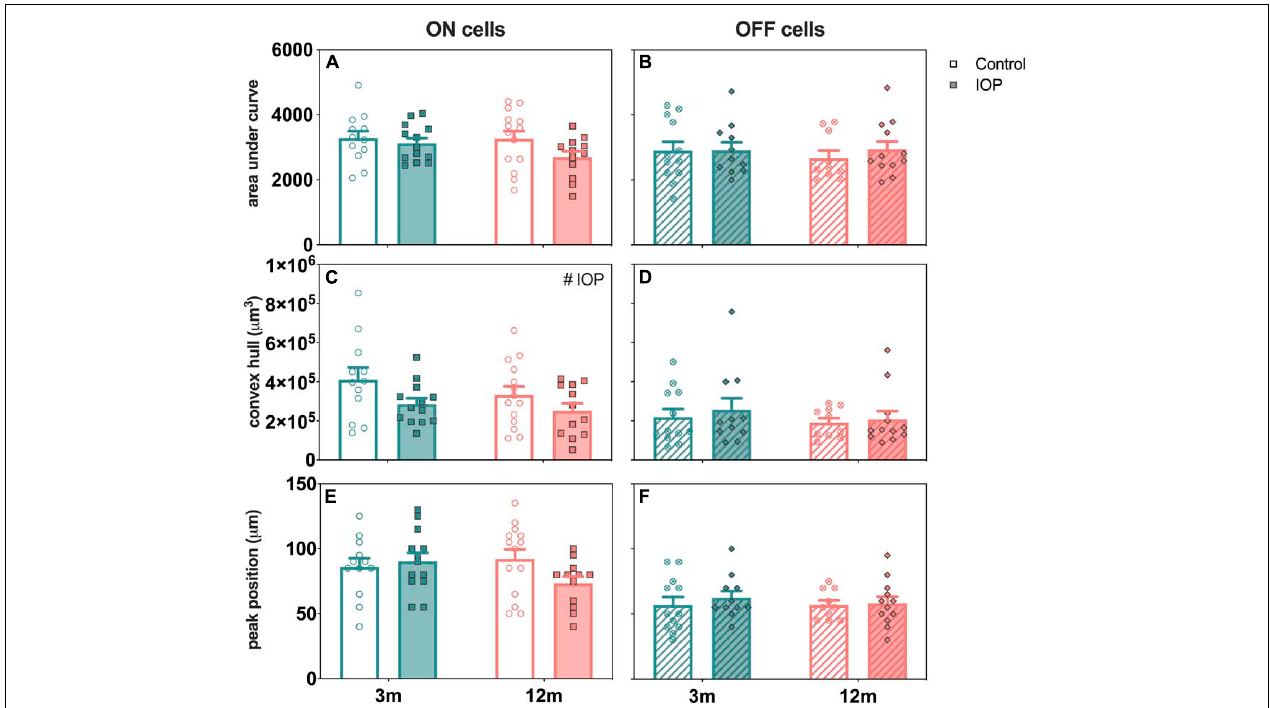
FIGURE 8 | Age comparison of ON (left column) and OFF (right column) RGCs in 3- and 12-month-old eyes 7 days after IOP elevation. (A,B) Area under curve in 3-month-old (teal) and 12-month-old (orange) eyes for control (unfilled bars) and IOP-treated (filled bars) of (A) ON (solid bars) and (B) OFF (patterned bars) RGCs. (C,D) Convex hull volume. (E,F) Peak position. 3-month-old ON [control, n = 12 cells (4 animals); treated, n = 13 cells (4 animals)] and OFF [control, n = 12 cells (4 animals); treated, n = 11 cells (4 animals)] RGCs. 12-month-old ON [control, n = 14 cells (3 animals); treated, n = 12 cells (4 animals)] and OFF [control, n = 10 cells (4 animals); treated, n = 12 cells (4 animals)] RGCs. Error bars, SEM; #, mixed effects model p < 0.05.